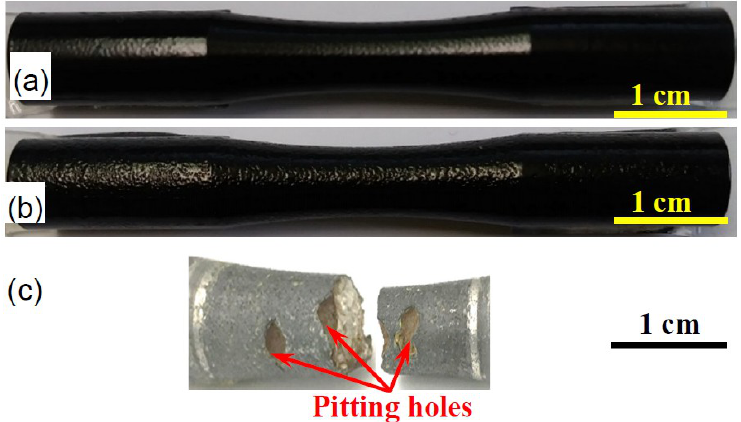
Figure 8. Surface topography of the AZ31B Mg alloy samples ( a ) before and ( b , c ) after corrosion fatigue tests: ( a ) CS + EP, ( b ) CS + EP sample after 10 M cycles at a stress amplitude of 80 MPa and ( c ) CS sample after ~3.7 million cycles at a stress amplitude of 40 MPa.